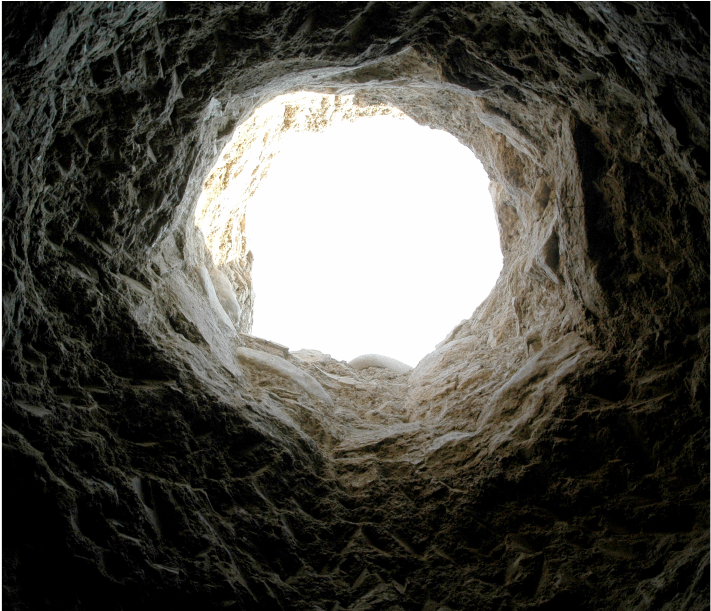
Figure 3. LC well in Building 2, Arediou Vouppes . Photo: S.